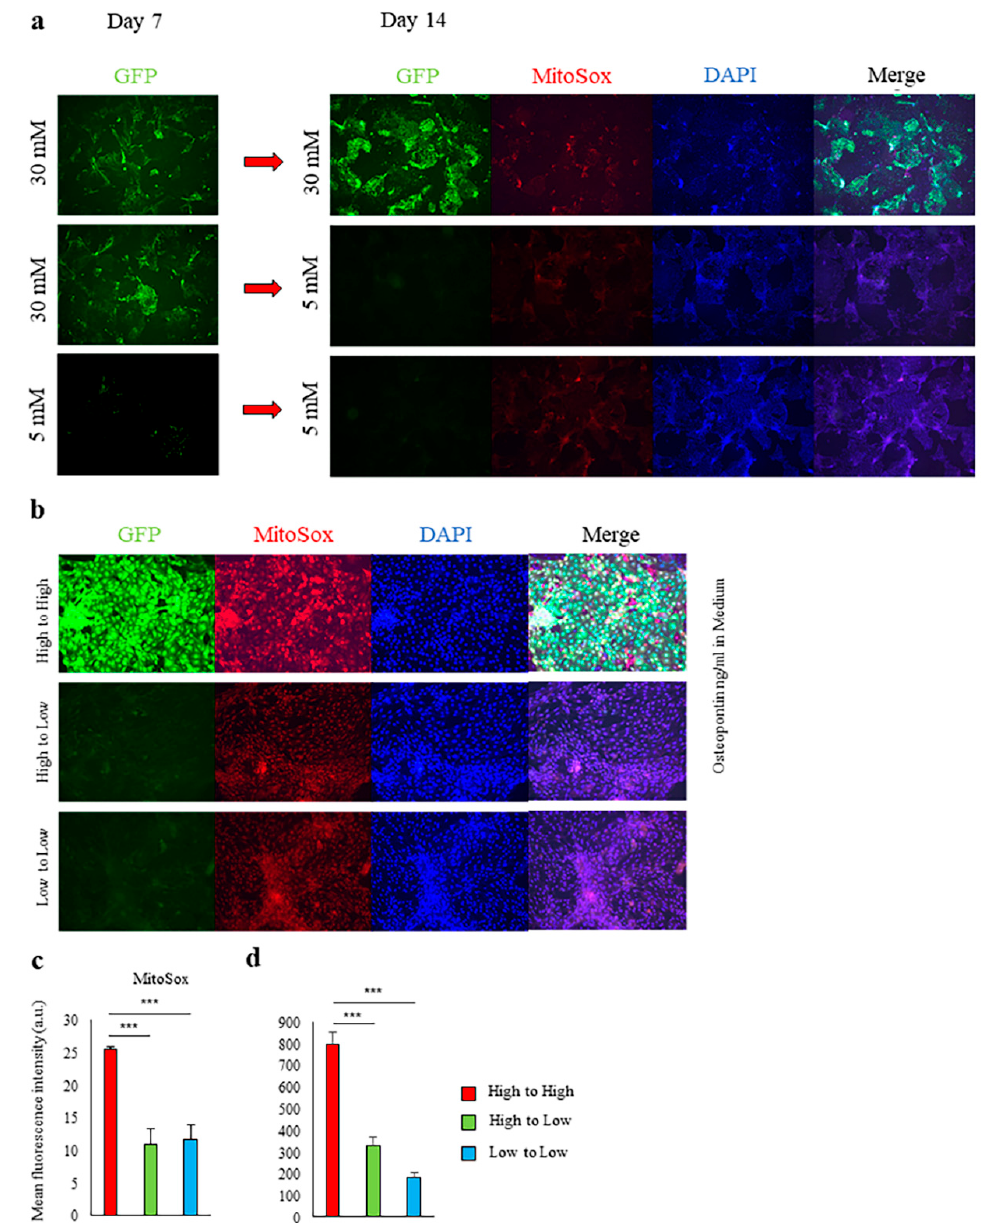
Figure 2. Glycemic control reversibly regulated Spp1 transcriptional activity of renal proximal tubular epithelial cells. ( a , b ) Primary culture of proximal tubular epithelial cells (PTEC) derived from enhanced green fluorescent protein (EGFP)- Spp1 knock-in reporter mice. PTEC were cultured in 5 mM (“low”) or 30 mM (“high”) glucose conditions for 7 days, then cultured in the indicated conditions for another 7 days. Microscopic analysis of fluorescence of 4 ʹ ,6 ‐ diamidino ‐ 2 ‐ phenylindole (DAPI) and MitoSOX staining and of EGFP ‐ Spp1 expression. ( c ) Mean fluorescence intensity of MitoSox in PTEC ( n = 4–6 per group). ( d ) Osteopontin (OPN) in the culture supernatants was assessed by enzyme ‐ linked immunosorbent assay ( n = 6 per group). Data are shown as means, and error bars depict SEM. *** p < 0.001.